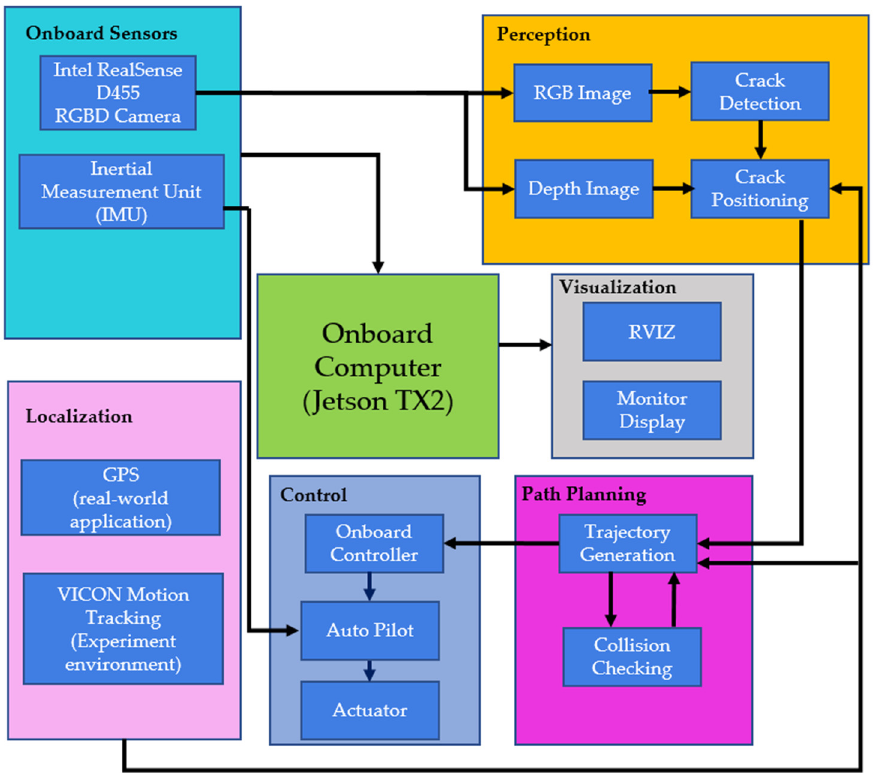
Figure 2. The software architecture of our UAV inspection system.